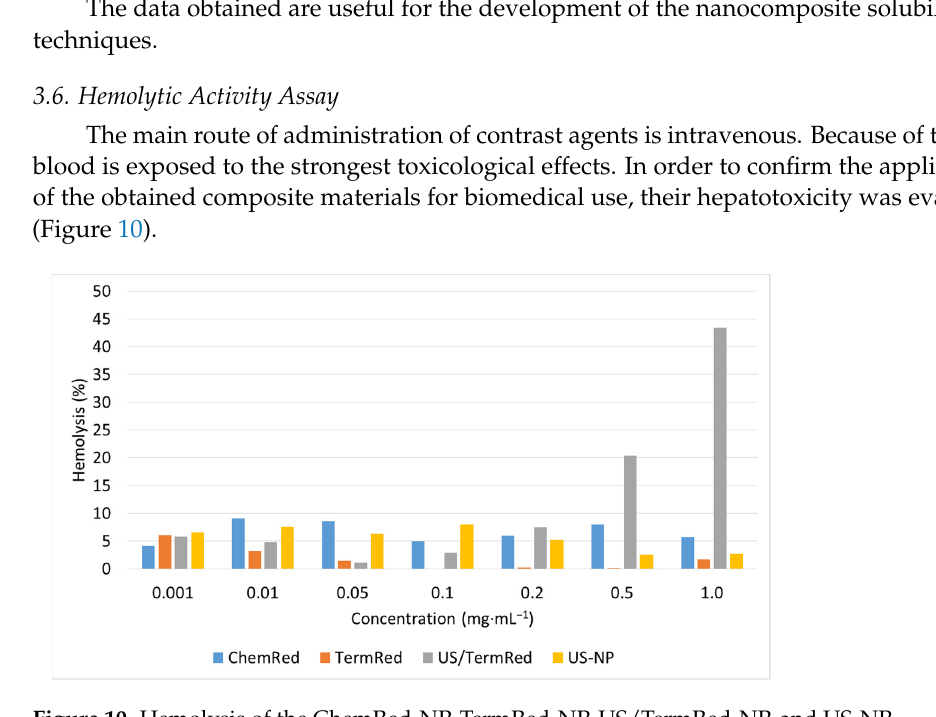
Figure 10. Hemolysis of the ChemRed-NP, TermRed-NP, US/TermRed-NP, and